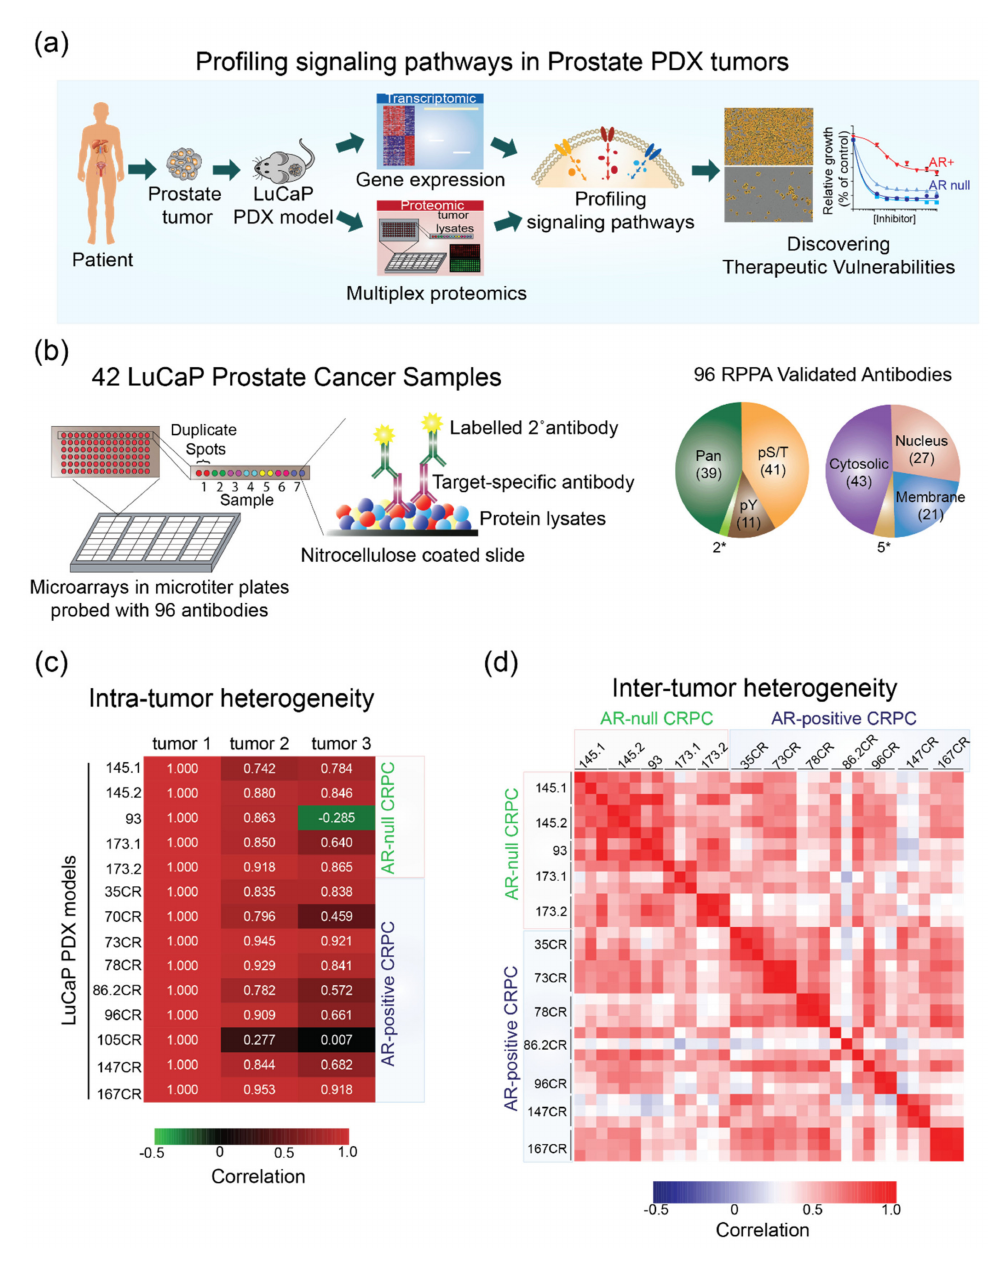
Figure 1. Proteomic profiling of signaling pathways in LuCaP PDX tumors shows a high degree of intra-tumor and inter-tumor correlation. ( a ) A schematic showing the overall goal and design of our study to integrate proteomic and transcriptomic profiling in LuCaP PDX tumors. The resulting state of signaling pathways is then validated in model cell lines and PDX tumors using pathway-specific inhibitors. ( b ) A schematic illustrating RPPA and properties of validated antibodies used in this study. Right: pie charts showing the distribution of all antibodies tested and those yielding positive signals broken down by different targets, PTMs, and subcellular localization. * refers to antibodies detecting cleaved caspases. ( c ) A heatmap showing the correlation between three different tumor samples from each LuCaP PDX model. Sample tumor 1 is used as a reference, and the numbers indicate Pearson correlation. ( d ) A heatmap showing a strong positive correlation within AR-null and AR-positive LuCaP PDX